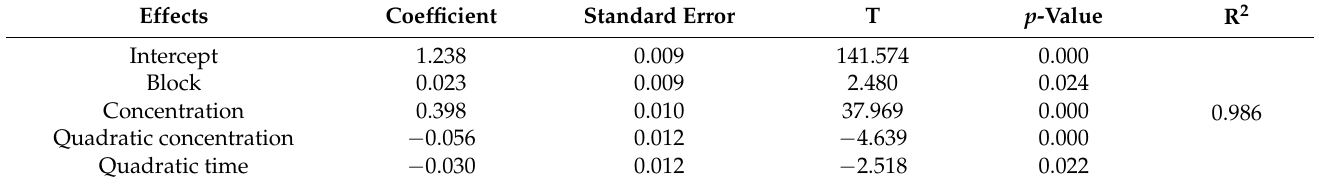
Table 4. Significant effects for the electrical conductivity parameter for coagulation, flocculation, and sedimentation (C/F/S) process using Moringa oleifera in the presence and absence of magnetite.